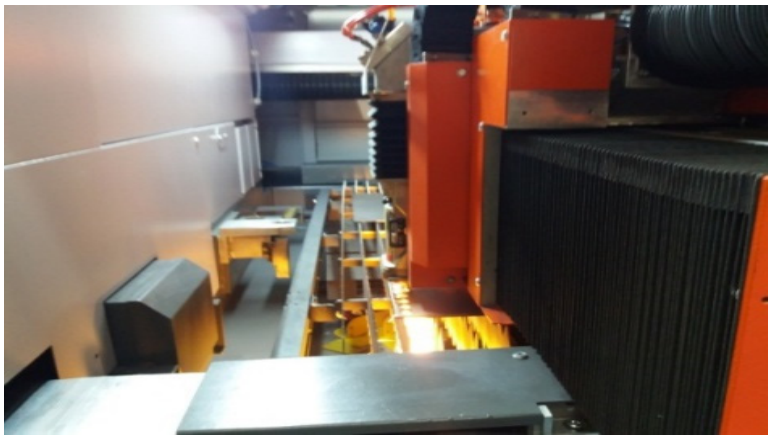
Figure 2. Laser ByAutonom 4020. The wavelength of the CO 2 laser beam is 10.6 µ m. The diameter of the laser beam D at the entrance to the lens is 20 mm, and the diameter of the spot is 0.2 mm. The conical nozzle through which the gas is directed has a diameter of 1.5 mm. Starting from the source, the laser beam reaches the lens with focal length of 190.5 mm, and is concentrated in the focus of the lens, where the incident intensity on the piece increases 103–104 times, compared to the value recorded before entering the lens, approximately 162.5 × 105 W/cm 2 . The focusing position of the laser spot was kept constant at +1 mm above the upper level of the blank, taking into account that the assistant gas is O 2 .